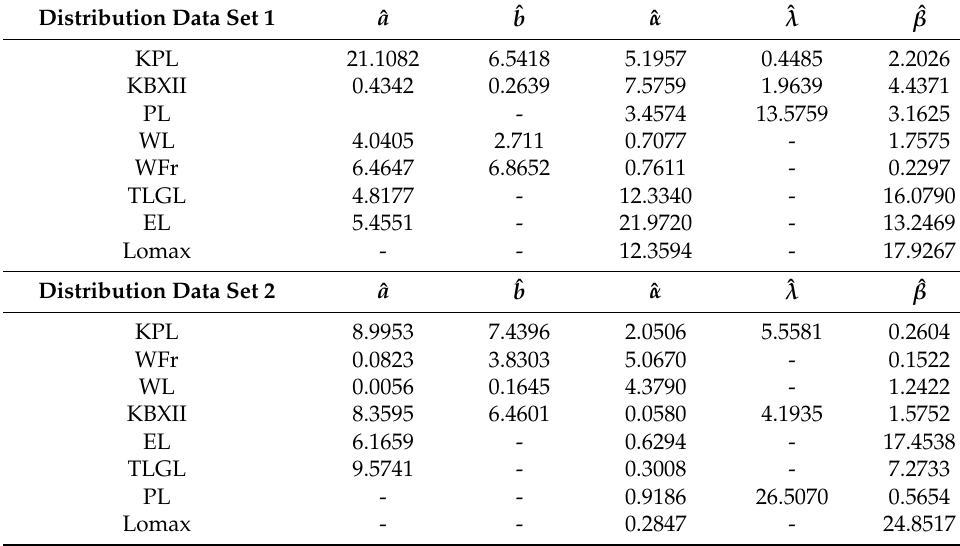
Table 3. MLEs of the considered distribution parameters for the data